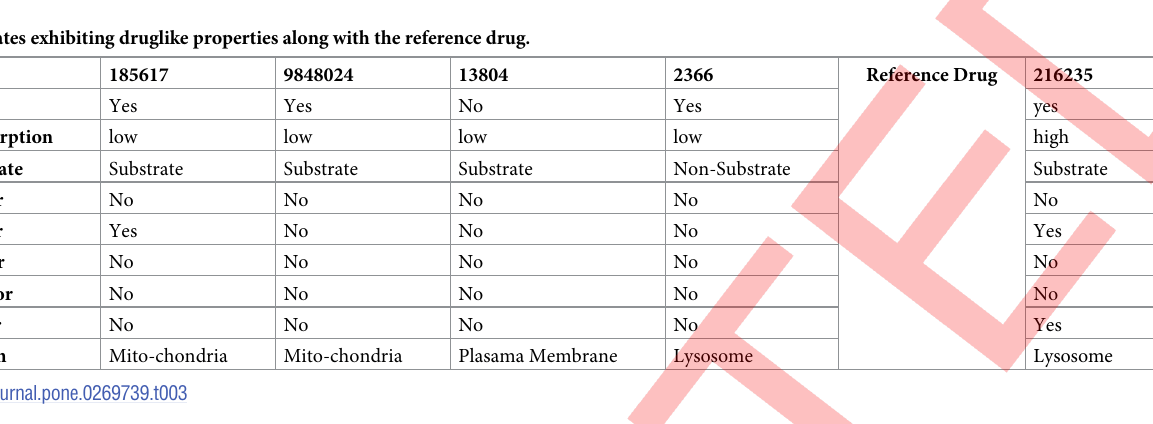
throughout the simulation period. Docked complexes RMSF plots are demonstrated in Fig 6 (A) and 6(B) . Scutellarin/Endothlien-1 and Gentiopicroside/Endothlien-1 complexes RMSF values were found between a range of 1.2 ± 3 Å & 1.2 ± 3.2 Å . Both complexes’ RMSF plots revealed minor differences.